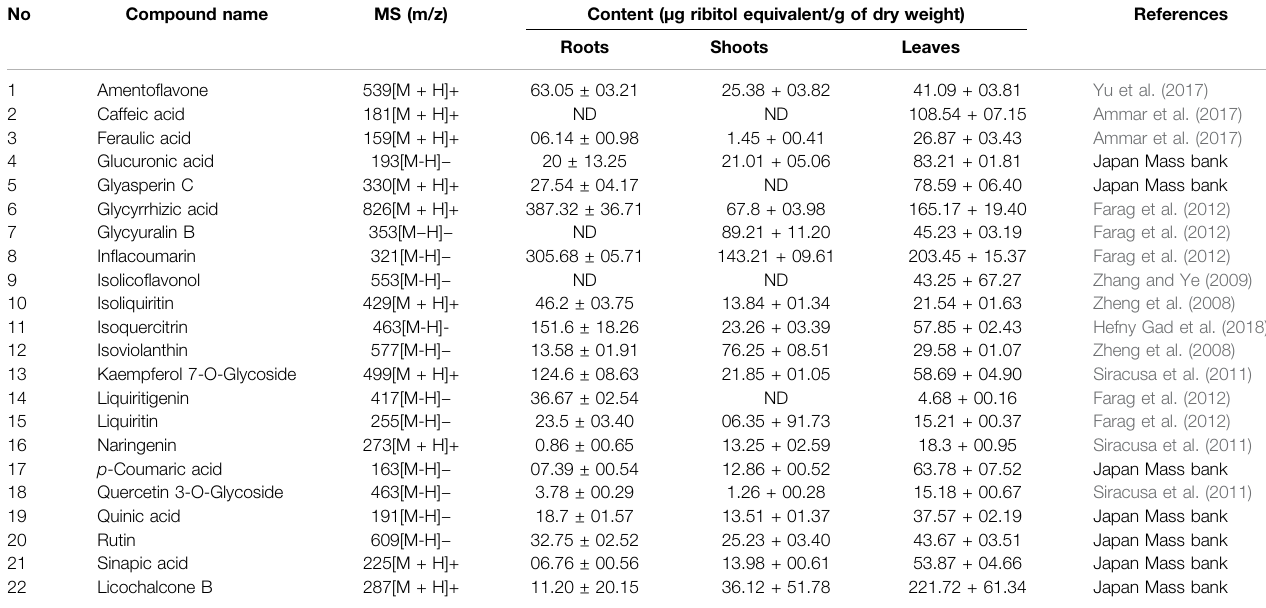
TABLE 2 | Comparative quanti fi cations of some major bioactive compounds presented in different parts of G.